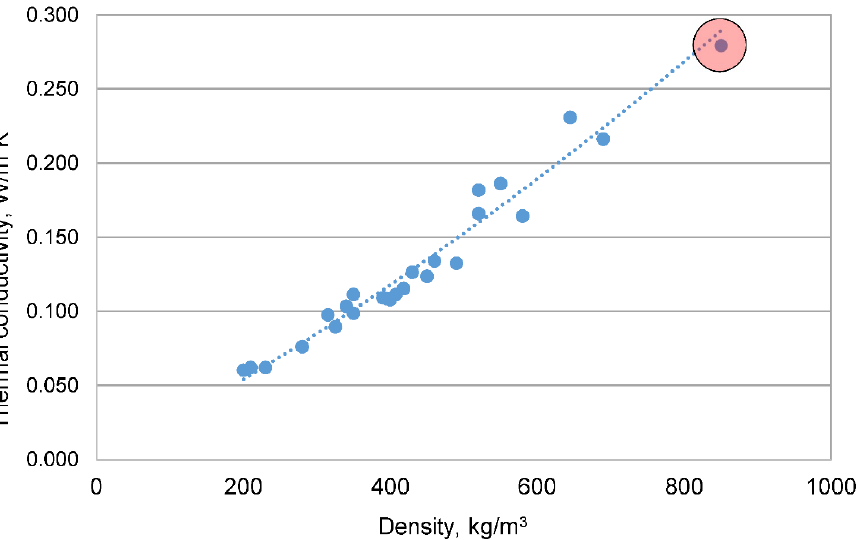
Figure 8. Relation between density and coefficient of thermal conductivity. The result for a tested sample is marked with a red circle.